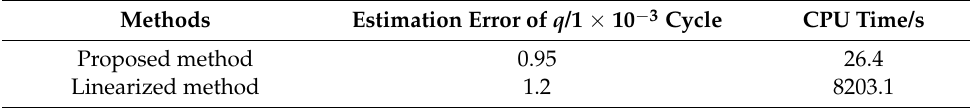
Table 3. Comparison of CPU time and estimation error of q .